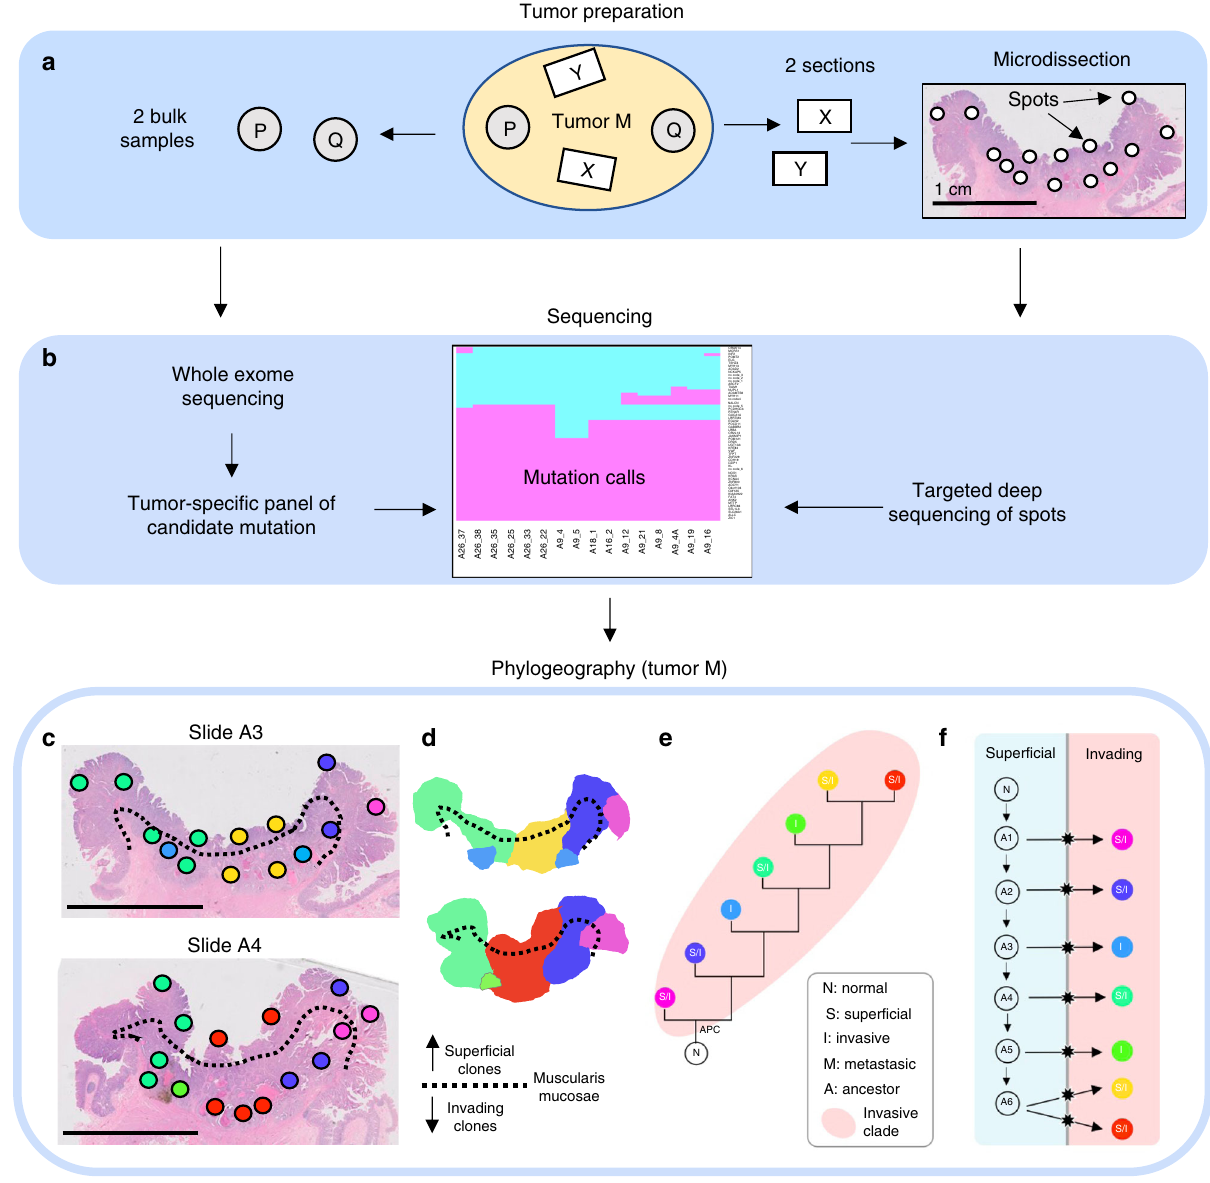
Fig. 2 Study design. a From each tumor, two bulk samples from opposite sides were obtained (P, Q) and two microscope sections (X, Y) were collected during routine clinical work (arbitrary locations). From the microscopic sections, small spots (2 – 5 glands each) were microdissected using SURF technology. b After whole-exome sequencing of the bulk samples P and Q, tumor-speci fi c mutation panels with ~50 candidate mutations were designed. For each spot from the sections X and Y, targeted deep re-sequencing of the candidate mutations was performed. Because individual spots were clonal, mutations were called using a noise threshold for variant allele frequencies (VAF) at 5%. c Spot genotypes (here for tumor M) were identi fi ed and localized on the sections and sections were annotated for super fi cial and invasive regions (scale bar: 1 cm). d Invasion was de fi ned as migration below the muscularis mucosae (dotted line). Contiguous clone maps were derived from the spot topographies. e Maximum parsimony algorithms were used to reconstruct phylogenetic trees for the subclones. f The ancestry of invasive subclones was reconstructed under the assumption that cells can migrate from super fi cial to invasive regions, but not vice